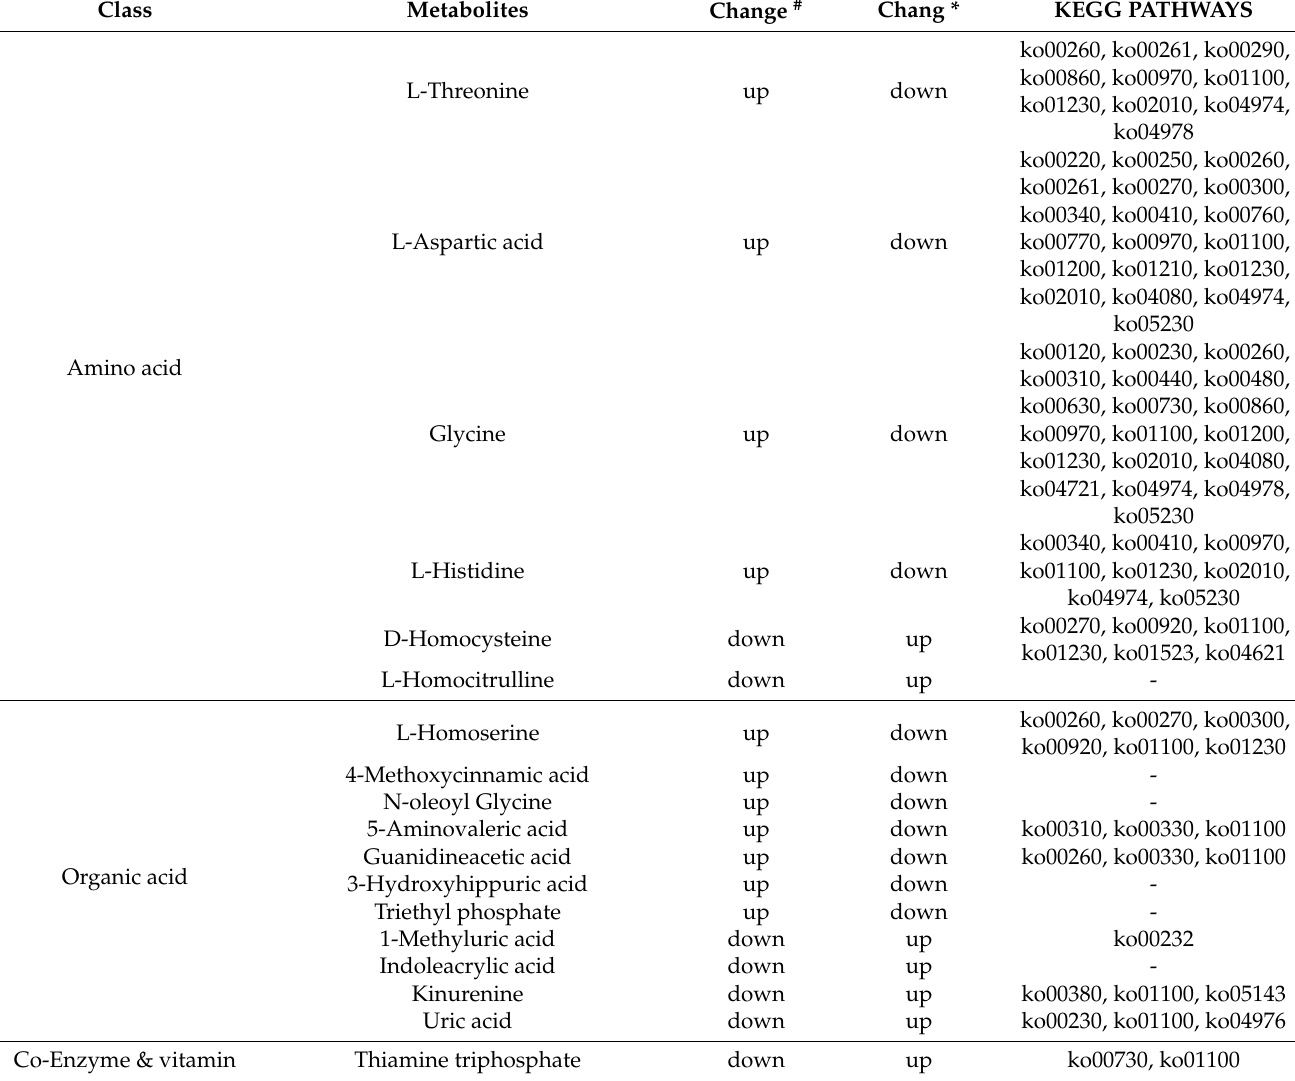
Table 2. The serum differential metabolites and their KEGG enrich